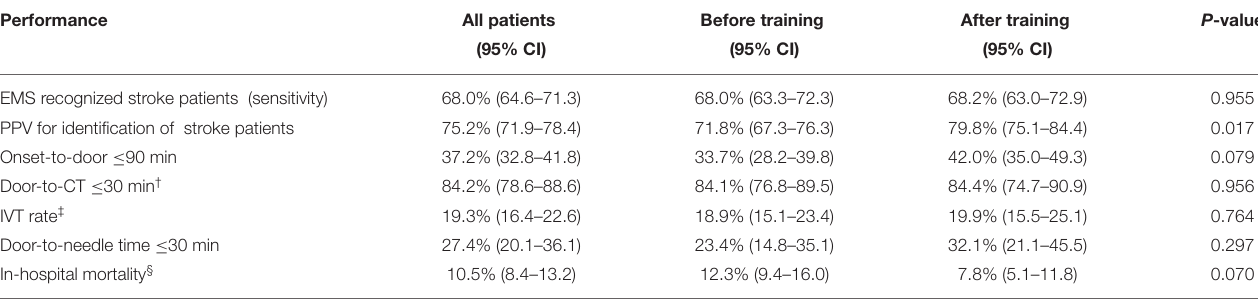
TABLE 3 | Emergency medical services performance and hospital-based outcomes among 916 suspected or confirmed strokes before and after the training.